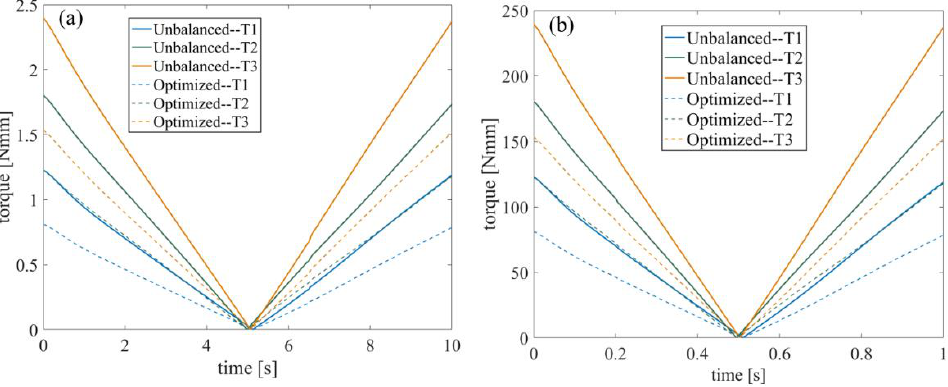
Figure 14. The torque of the unbalanced and optimized SPR at ( a ) “low” and ( b ) “high” for trajectory 2.